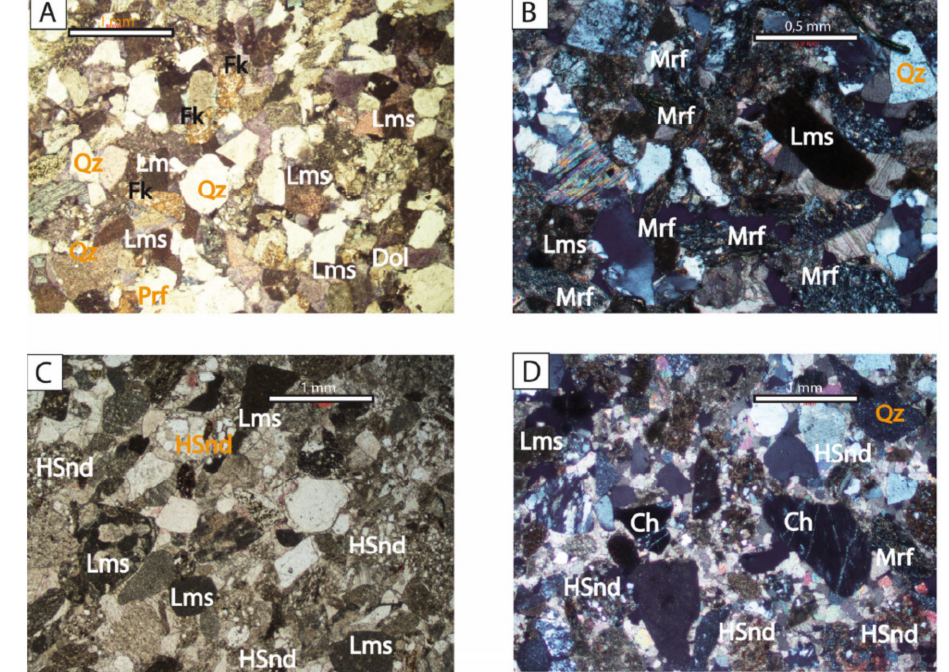
Figure 5. Optical photomicrographs of the described petrofacies. ( A ) General view of “carbonate extrabasinal enriched” petrofacies, with abundant micritic and bioclastic limestone (Lms) fragments and quartz (Qz), K-feldpar (Fk), plutonic rock fragments (Prf), and dolomite grains (Dol) (XPL). Sample ROD1, Belsu é -Atar é s Formation. ( B ) “Siliciclastic dominant” petrofacies characterized by the highest contents of quartz (Q), metamorphic rock fragments (Mrf), and limestone grains (Lms) and by the absence of hybrid sandstone rock fragments (XPL). Sample GAL4, Campodarbe Formation. ( C ) General view of “hybrid clast-dominated” petrofacies showing the large amount of hybrid sandstone rock fragments (HSnd) and limestone rock fragments (Lms) (PPL). ( D ) Appearance of “mixed lithic and carbonatic” petrofacies, showing the coexistence of hybrid sandstone rock fragments (HSnd) with abundant carbonatic (Lms) and siliciclastic grains radiolarite (Ch), quartz (Qz), and metamorphic grains (Mrf)